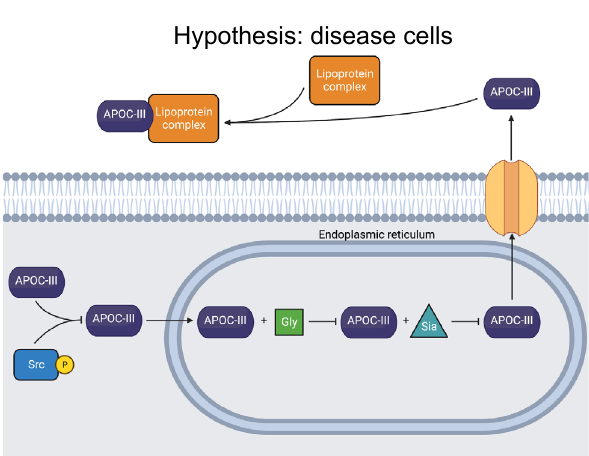
Figure 3. Diagram showing O-glycosylation, sialylation, phosphorylation, and extracellular transport of APOC-III. ( A ) APOC-III is O-glycosylated and sialylated in the endoplasmic reticulum [76,77]. After extracellular transport, it becomes a constituent of lipoproteins, regulating lipid transport and metabolism [71]. ( B ) Alternatively, T74 is phosphorylated, precluding O-glycosylation [31]. ( C ) The mutation T74A abolishes the O-glycosylation and phosphorylation site [23,24,74,75]. Inhibited O- glycosylation and phosphorylation of APOC-III may be related to dysfunctional lipid metabolism, though secretion is not prevented